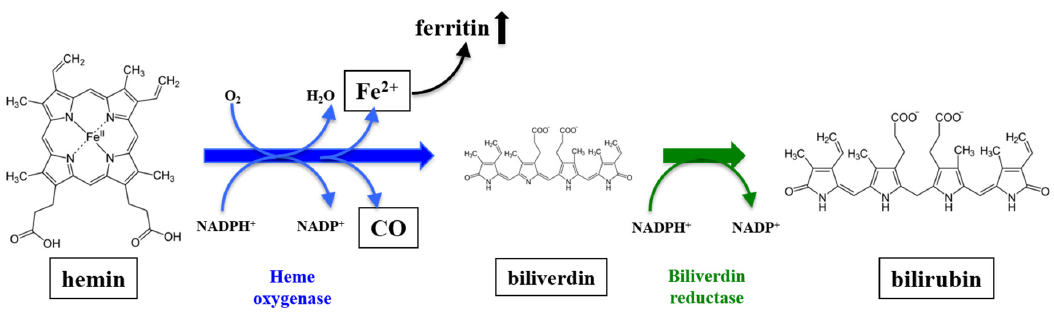
Figure 1. Heme oxygenase pathway. CO: carbon monoxide.